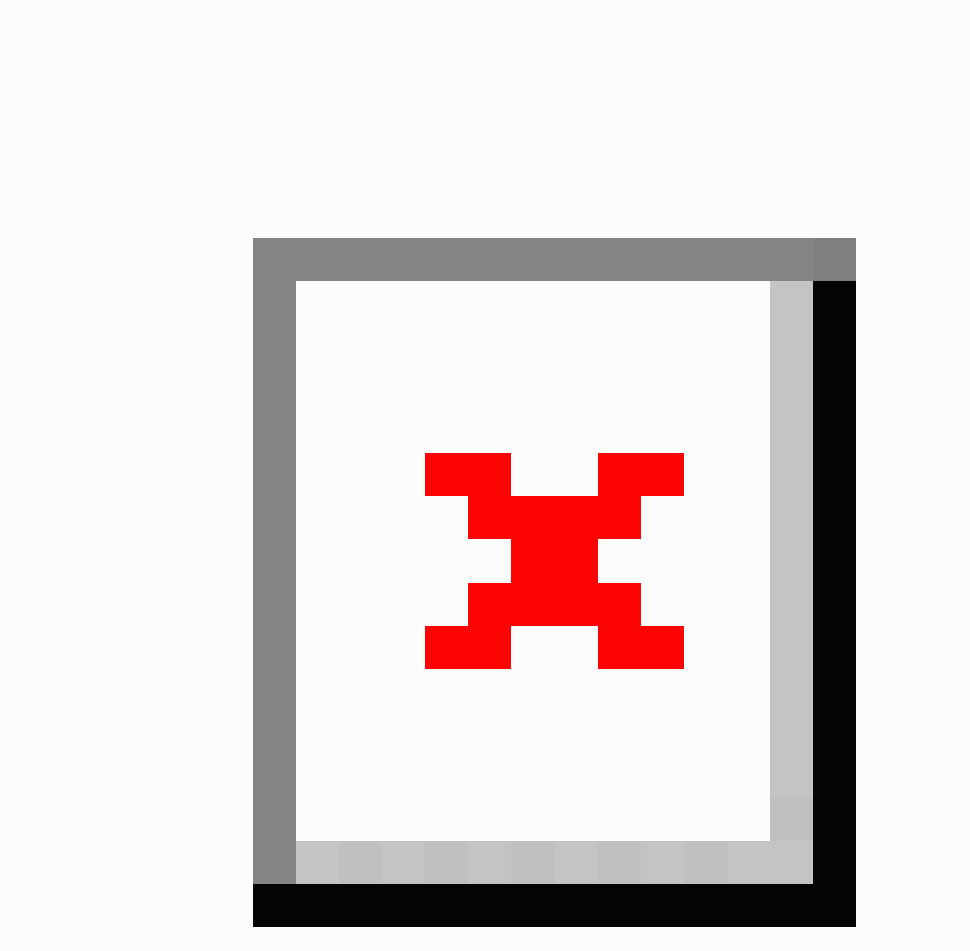
Step Two Power distributions in ranked data have skewed distributions [14]. To visually determine the skewness, or asymmetry of the